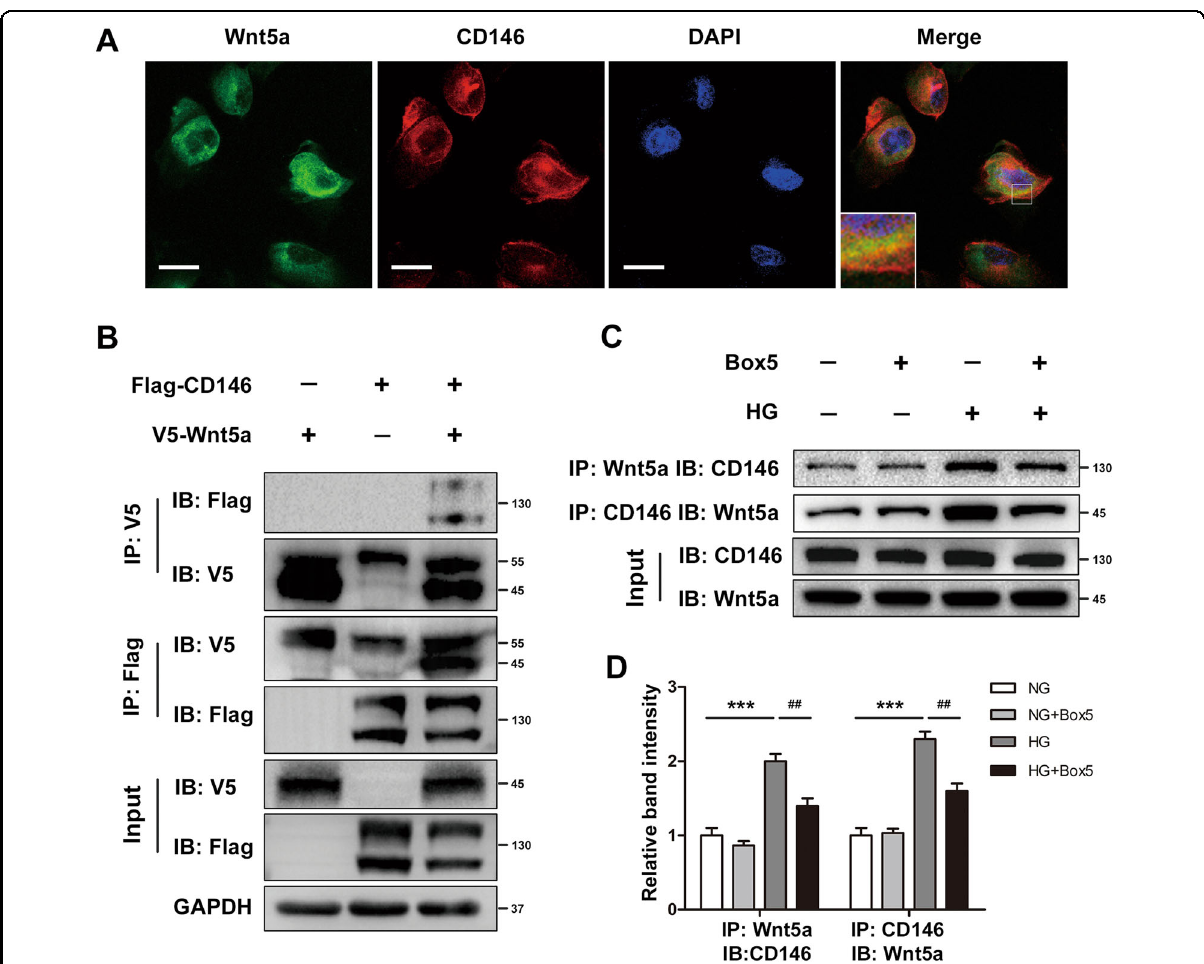
Fig. 8 CD146 binds to Wnt5a directly in HK-2 cells. A Immuno fl uorescent double staining of Wnt5a and CD146 in HK-2 cells. Images were taken with a confocal microscope (original magni fi cation ×1000, bar = 10 µm). B One microgram of V5-tagged Wnt5a and 1 μ g of FLAG-tagged CD146 or 2 μ g of each plasmid were transfected into HK-2 cells for 48 h. Cells were lysed and incubated with anti-V5 antibody or anti-FLAG antibody.